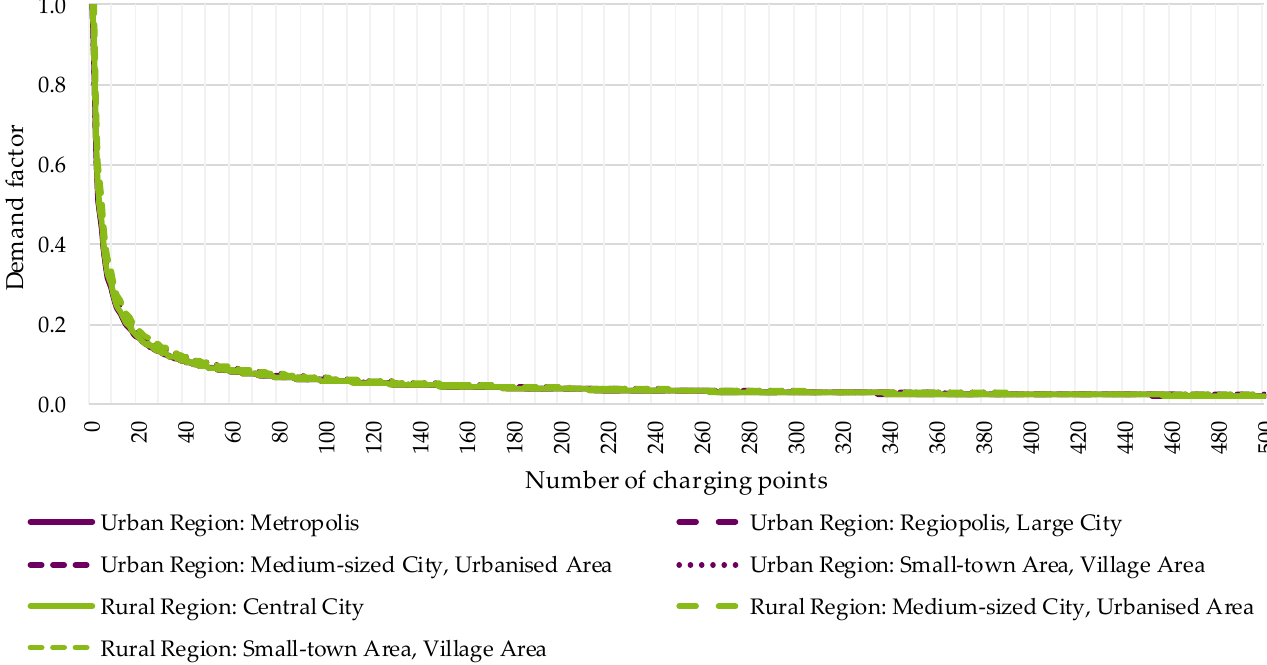
Figure 18. Demand factors (ordinate) for 350 kW charging power and seven different area types.